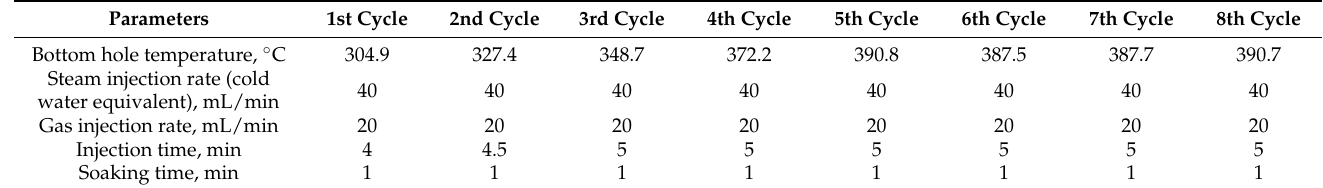
Table 4. Parameters of supercritical multi-thermal fluids